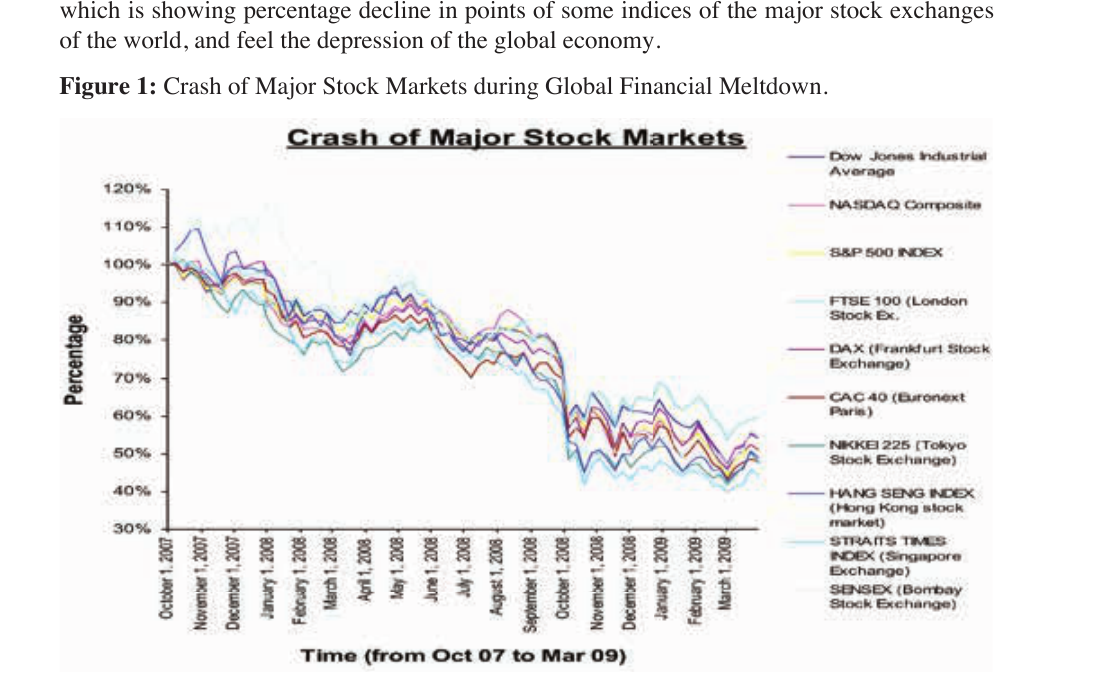
Figure 1: Crash of Major Stock Markets during Global Financial Meltdown.